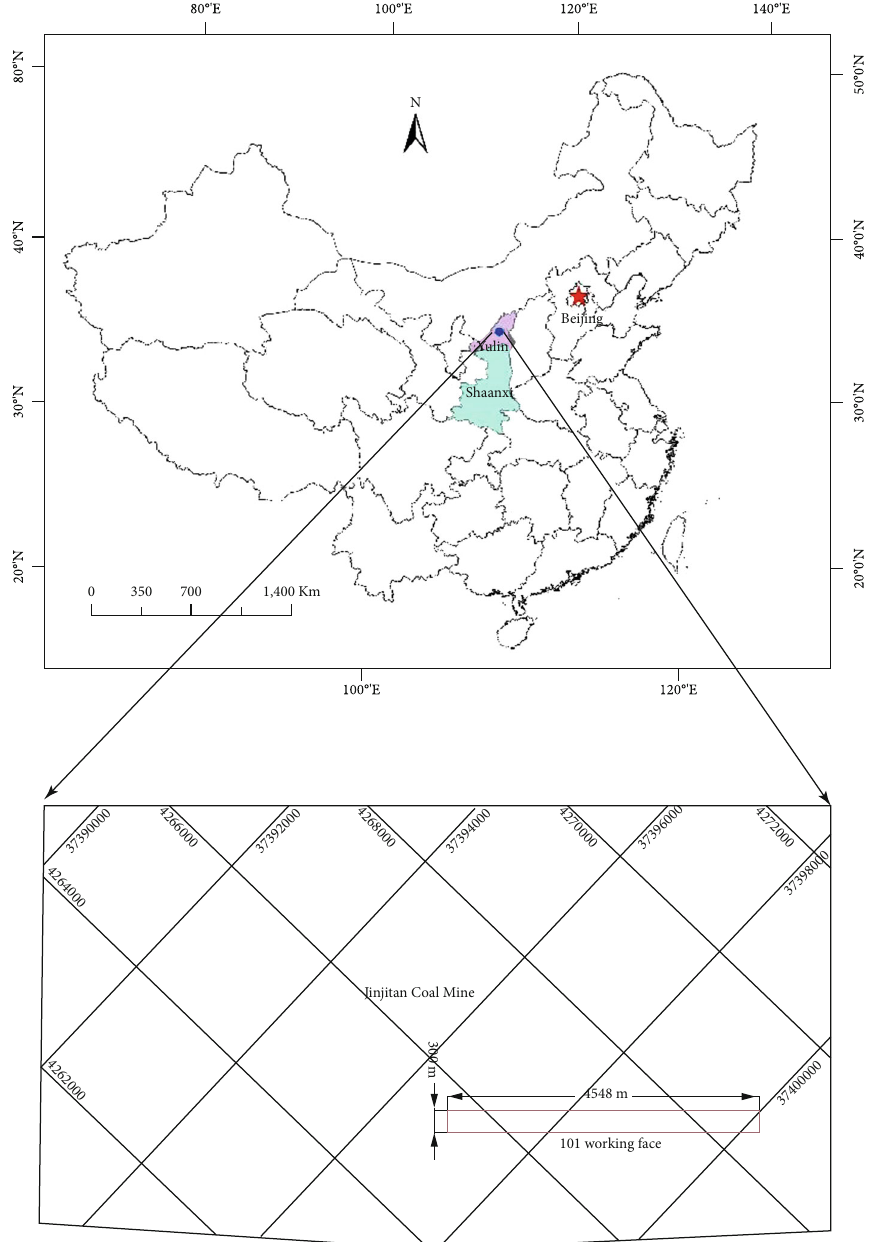
Figure 1: Location of Stope #101 and Jinjitan Coal